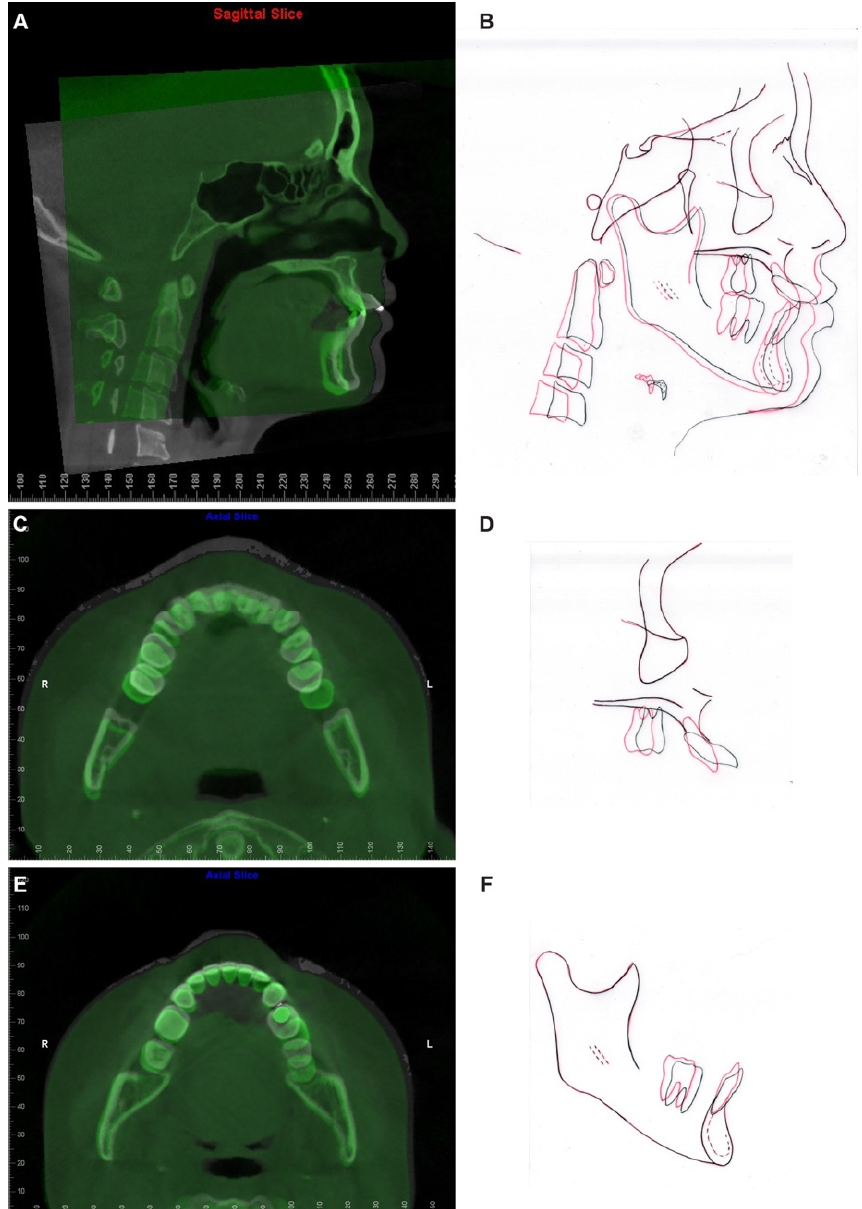
Figure 12. CBCT and cephalometric superimposition. ( A ) The sagittal slice at the maxillary left central incisor level of pre- (white) and post- (green) treatment CBCT images superimposed based on cranial base. ( B ) The superimposition of pre- (black) and post- (red) treatment cephalometric tracings superimposed based on cranial base. ( C ) The Axial slice of pre- (white) and post- (green) treatment CBCT images superimposed based on the cranial base. The slice was captured at the level of the cervical region of maxillary anterior teeth to demonstrate the amount of maxillary molar distalization achieved during treatment. ( D ) The superimposition of pre- (black) and post- (red) treatment cephalometric tracings of the maxilla. ( E ) The Axial slice of pre- (white) and post- (green) treatment CBCT images superimposed based on mandibular symphysis. The slice was captured at the level of the cervical region of mandibular anterior teeth to demonstrate the amount of mandibular molar distalization achieved during treatment. ( F ) The superimposition of pre- (black) and post- (red) treatment cephalometric tracings of the mandible.